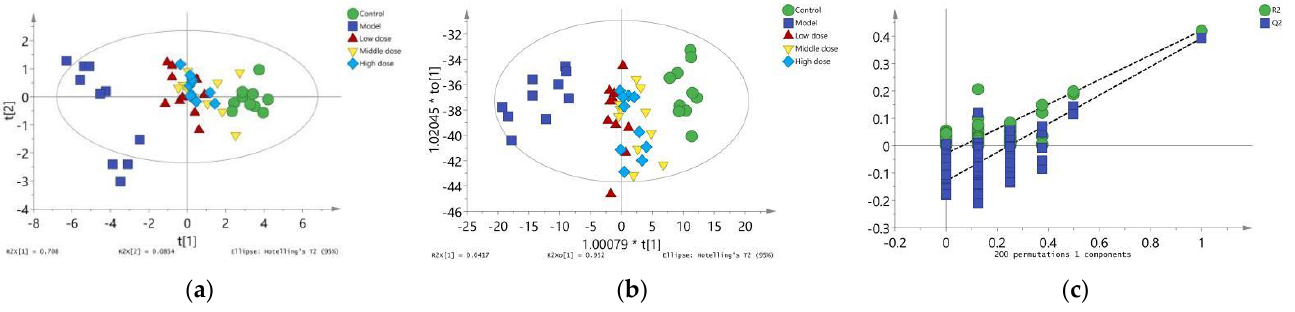
Figure 7. Results of multivariate statistical analysis. ( a ) Principal component analysis diagram; ( b ) Orthogonal partial least squares discriminant analysis diagram; ( c ) Verification diagram of orthogonal partial least squares discriminant analysis.